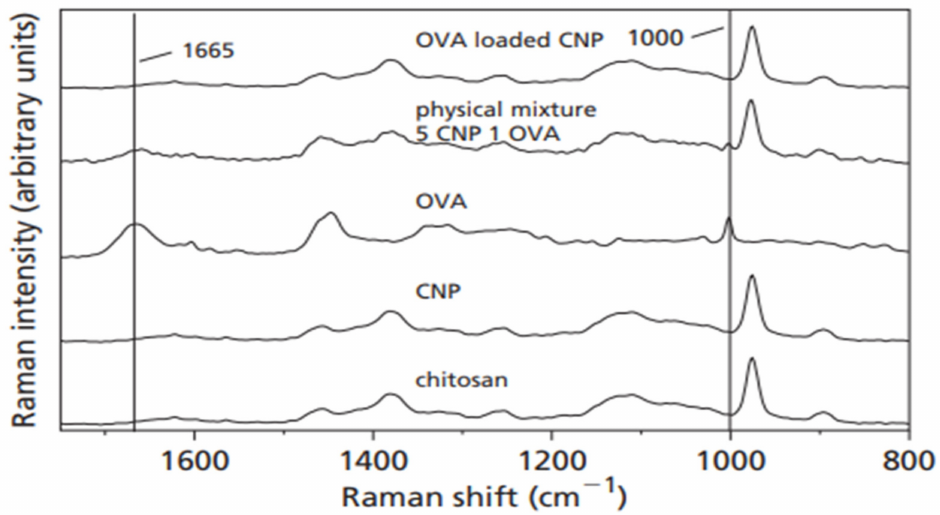
Figure 3. Raman spectra of chitosan, chitosan nanoparticles (CNPs), OVA, a physical mixture of 5:1 ratio of CNPs to OVA, and OVA-loaded CNPs (5:1 ratio of OVA to CNPs)